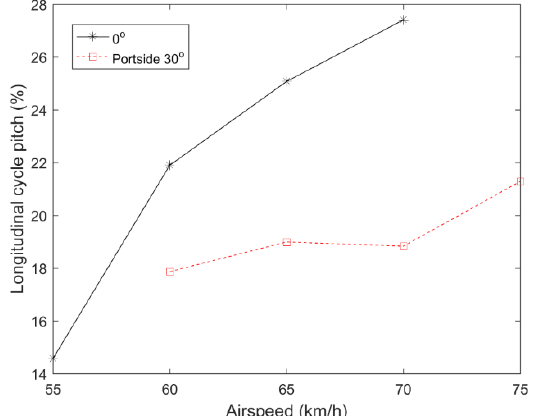
Figure 18. Longitudinal cycle pitch under 0° and portside 30° WOD conditions.